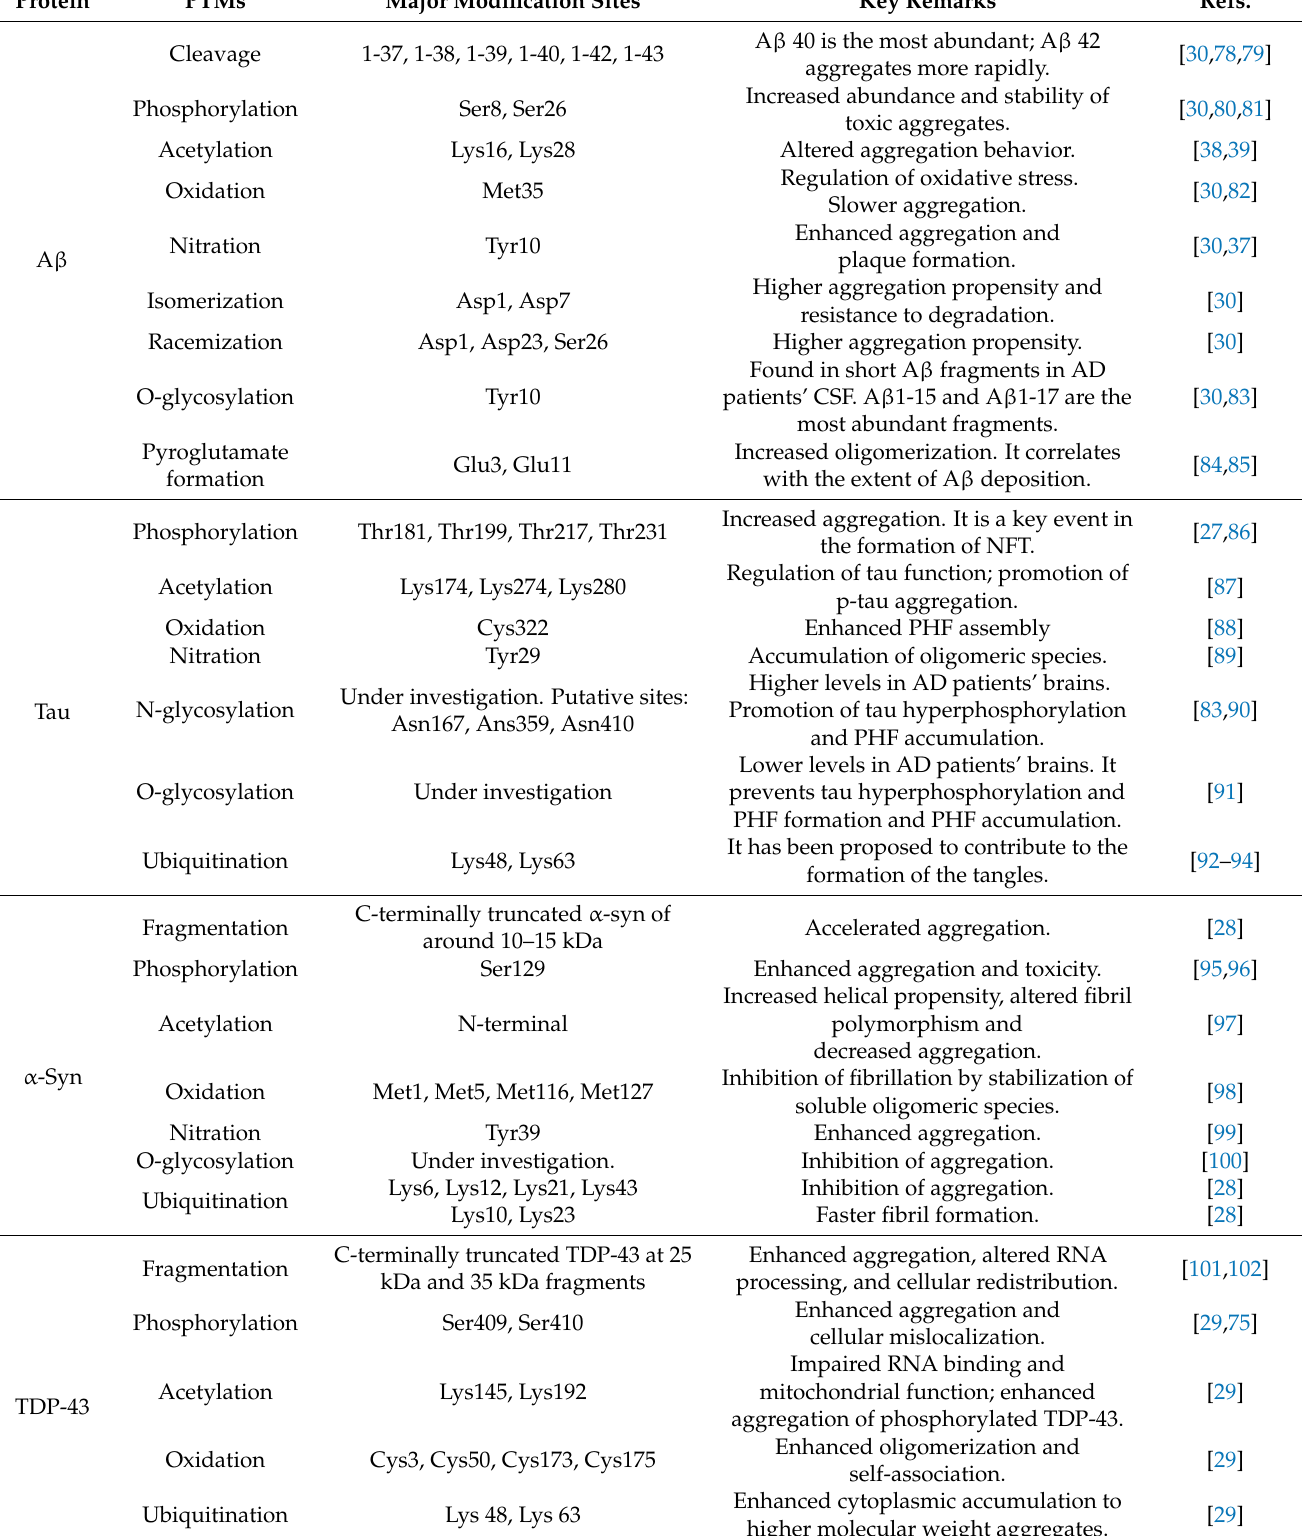
Table 1. Main PTMs of amyloidogenic proteins with diagnostic